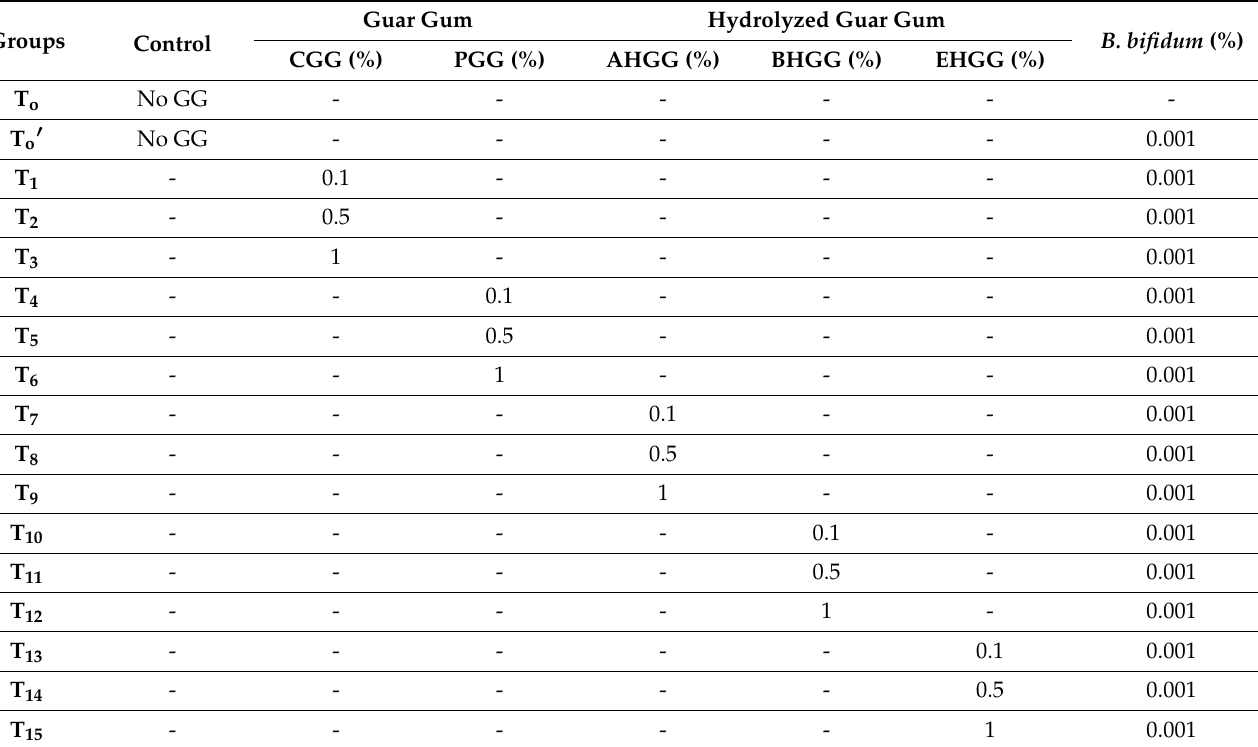
Table 1. Preparation plan of the developed yoghurt produced with guar